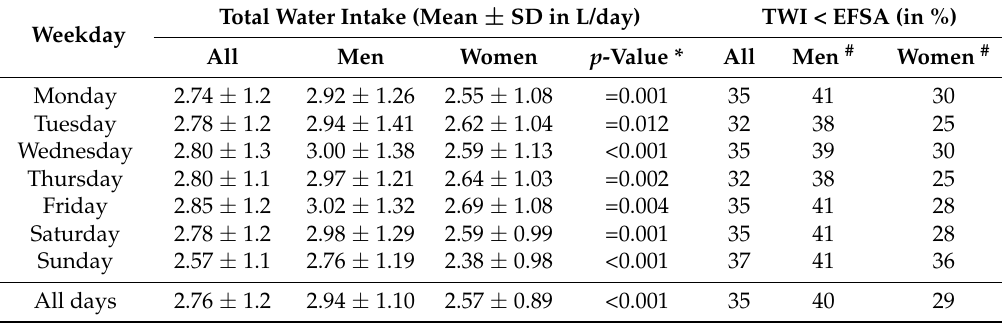
Table 1. Mean total water intake (TWI) on all weekdays and percentage of subjects with TWI below European Food Safety Authority (EFSA)